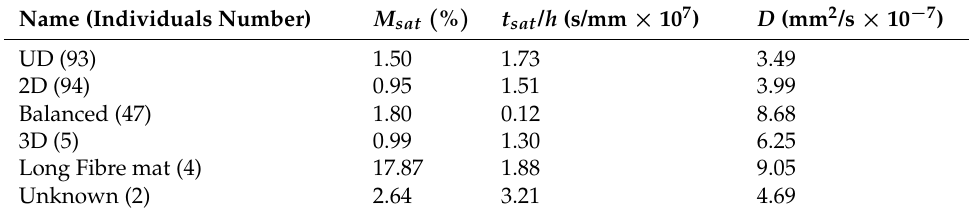
Figure 3. Evolution of ( a ) M sat , ( b ) t sat / h and ( c ) D as a function of the fibre volume fraction v f . Observing the reinforcement architectures used in the dataset, the composites com- posed of long fibre mats have a very important median absorbed mass uptake, which can be explained by the large voids created during its manufacture process (Table 5). This median absorbed mass uptake is quite similar for reinforcements arranged in one direction (UD), in two directions (2D), balanced, or in three dimensions (3D). It is slightly higher for UD and balanced reinforcements than for 3D. The median diffusivities are the greatest for the balanced and 3D composites, and the median saturation times are also the shortest for these two reinforcement configurations. The water molecules may have more directions to propagate, and and saturation is reached more rapidly. The literature is not uniform on this issue. Tang et al. found by modelling that their balanced woven fabrics diffused faster than their UD, particularly when the fibre waviness was greater [134]. For Yuan et al., the experimental data and modelling reveal a greater water mass absorbed in their 3D than in their UD. They also report a higher bound water proportion throughout the material [95]. On the other hand, Almudaihesh et al. observe that their UD composites absorb more water than their woven composites [135]. Finally, Wan et al. obtained a lower saturation mass uptake and diffusivity for their 3D than their UD. Their suggestion is that the moisture diffusion path is distorted in the 3D, which exerts a greater hindrance than for the UD [136]. Table 5. Medians of M sat , t sat / h and D as a function of architecture reinforcement. Entire box plots are available as Supplementary Materials (Figures S12–S14). UD: one direction, 2D: two directions, 3D: three